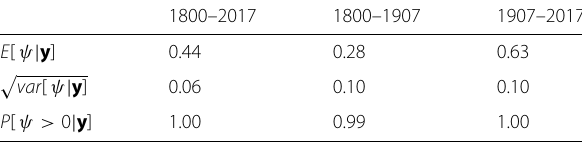
Table 5 Posterior moments ψ for CPI inflation